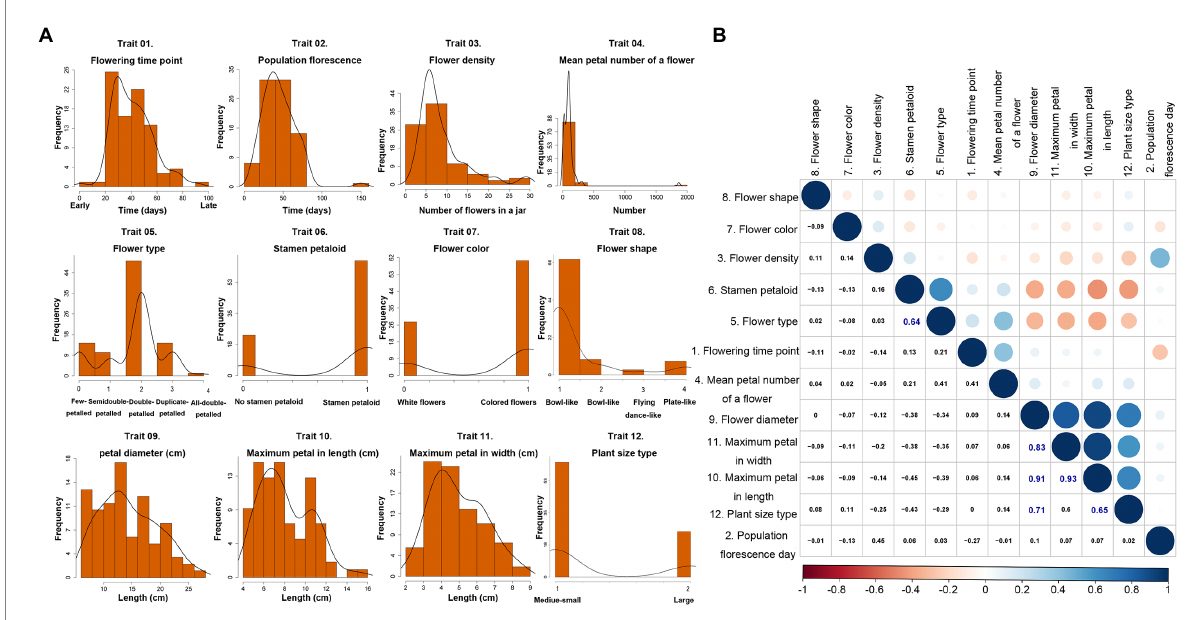
FIGURE 2 Diversity and relationships of 12 traits in 88 lotus accessions. (A) Frequency distribution of 12 traits in 88 accessions. (B) The pairwise Pearson correlations among 12 traits in 88 lotus